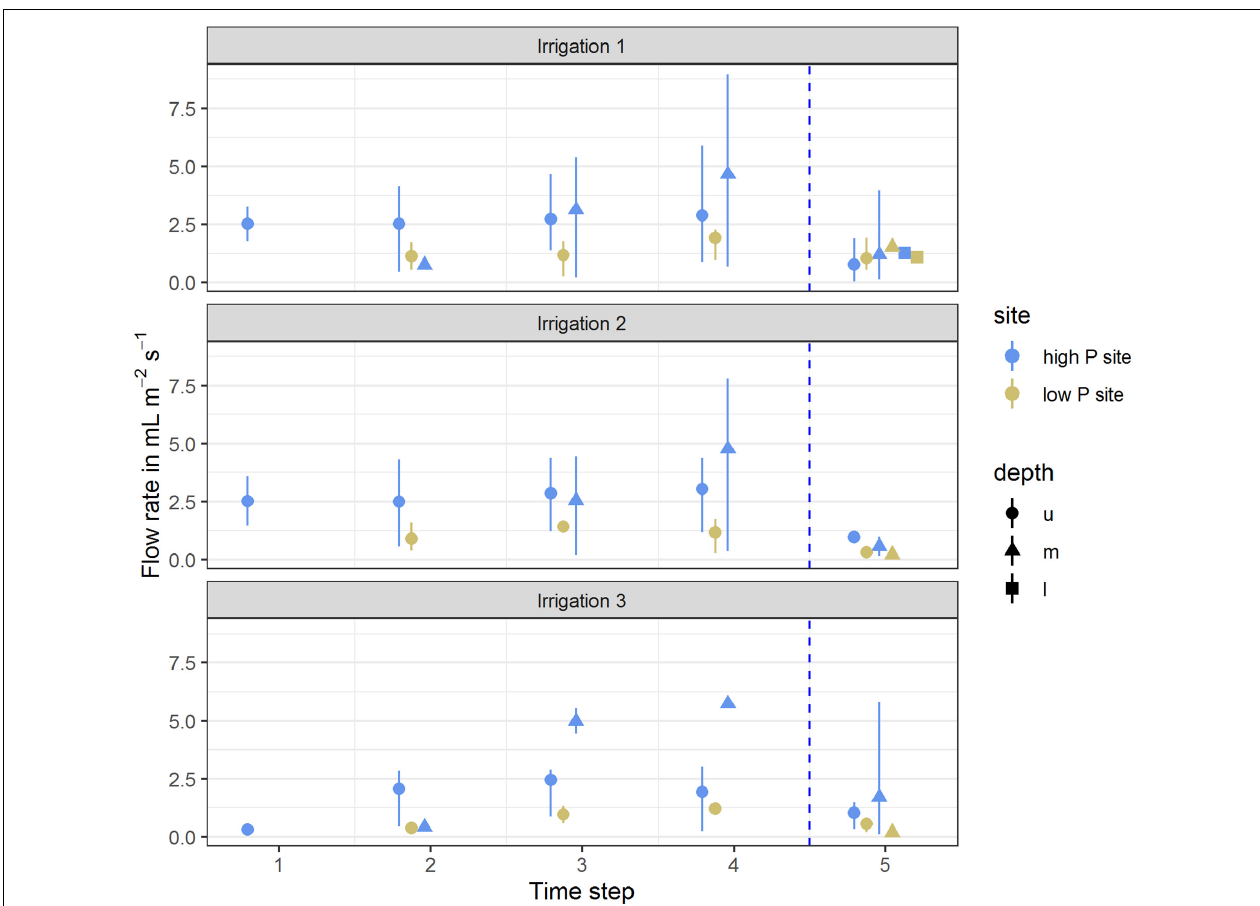
FIGURE 1 | Mean flow rates per time step of high (blue) and low (yellow) P sites. Arithmetic means were calculated from flow rates of all replicates per site for the respective time step. Ranges indicate the span from minimum and maximum values. Time steps 1–4 each represent 60 min of irrigation, time step 5 represents 180 min after the end of the irrigation. Depth represents the lysimeter installation depths (u – upper, m – middle, l – lower). Vertical dotted line represents the end of the irrigation